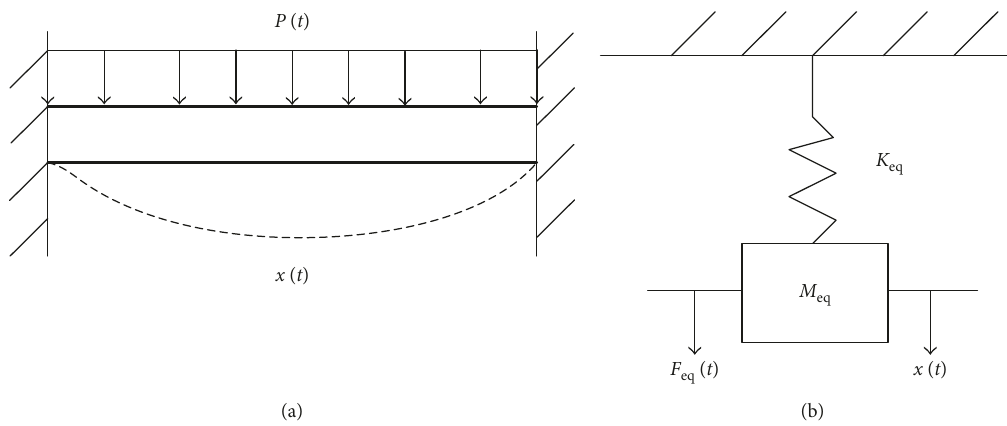
Figure 1: Equivalent single degree of freedom system: (a) real structure; (b) equivalent